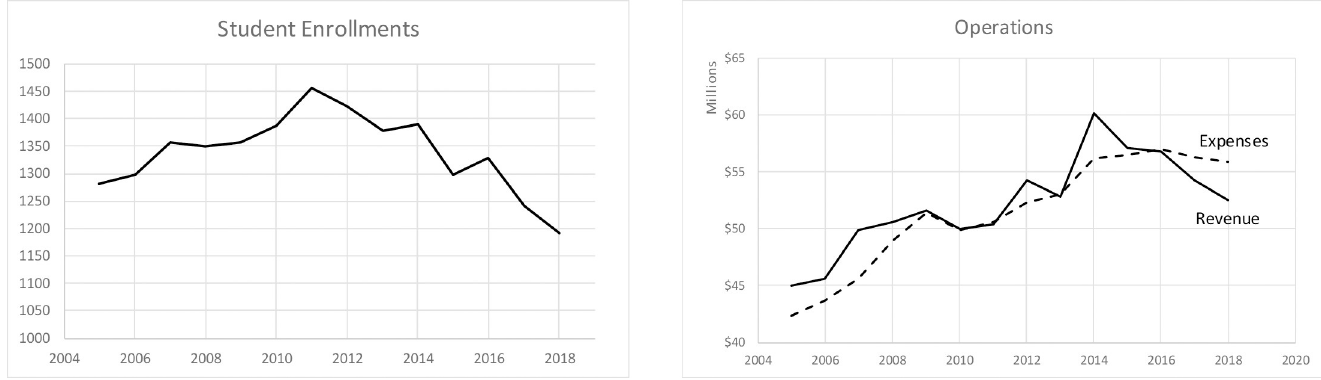
Fig 1. Student enrollments, revenue, and operating expenses at Hampshire College. Data sources: Financial reports of Hampshire College for 2005–2018 (available at https://www.hampshire.edu/business-office/financial-reports; Last accessed on April 15, 2020), [28, 29].